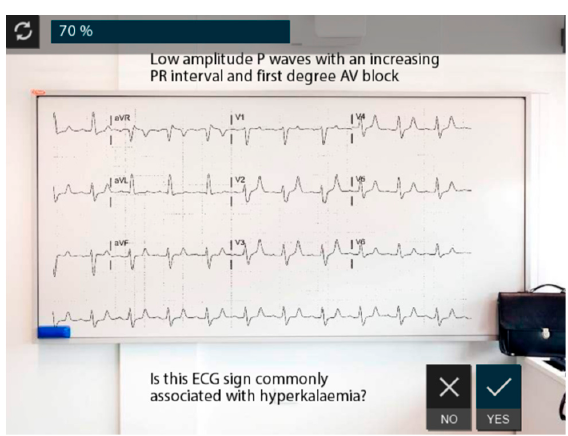
Figure 3. Part III of R2P: medical handover.